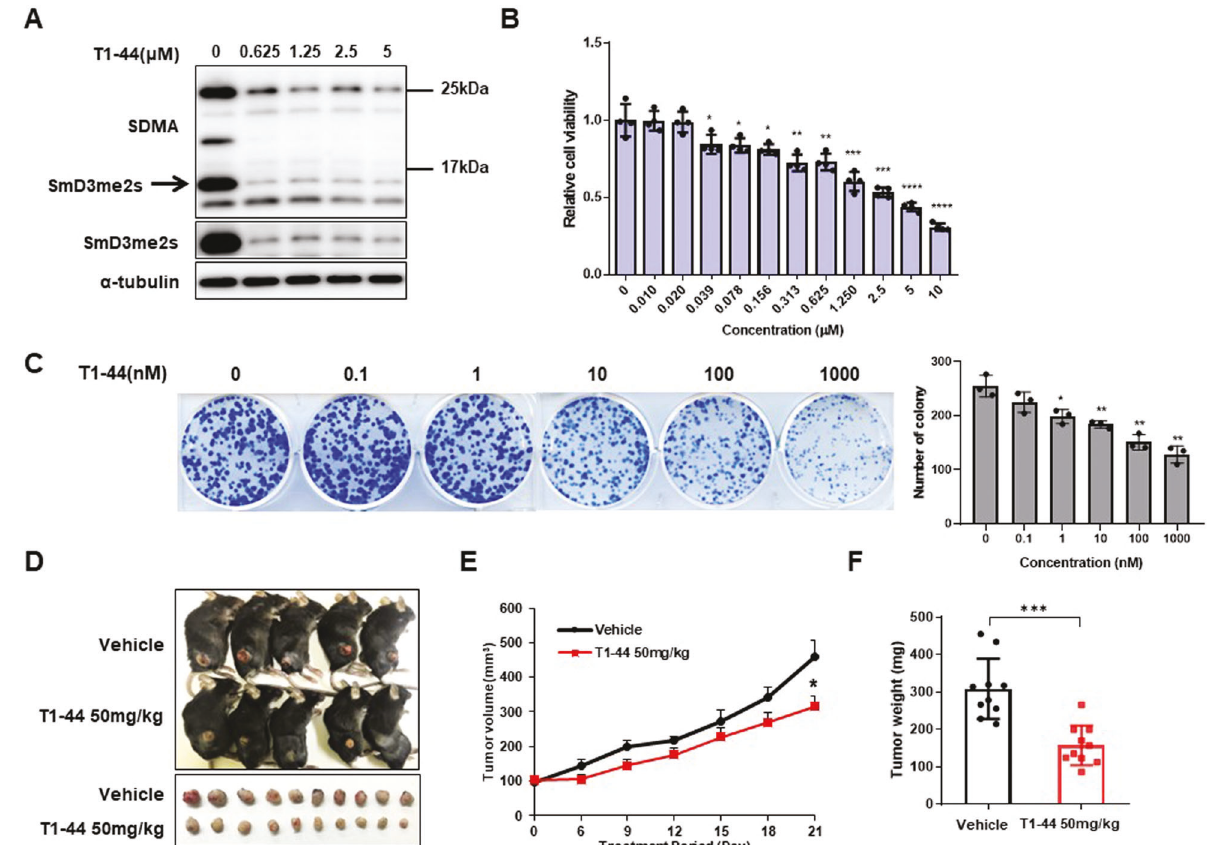
Fig. 1 In vitro and in vivo response of T1-44. A Dose-dependent inhibition of symmetric arginine di-methylation of SmD3 by T1-44 in Panc02 murine pancreatic cancer cells. B Cell viability of Panc02 by T1-44 measured by MTT assay. Means with SD of OD values were presented relative to control. C Colony formation assay by treatment with various concentrations of T1-44. Colonies were counted after treatment of T1- 44 for 2 weeks. D Administration of T1-44 (50 mg/kg, BID) to a subcutaneous tumor model of Panc02 cells. Individual tumor tissue was represented by tumor size for each group (bottom panel). E Graph of tumor volume measured every 3 days. F Tumor weights of vehicle and T1-44 treated groups at